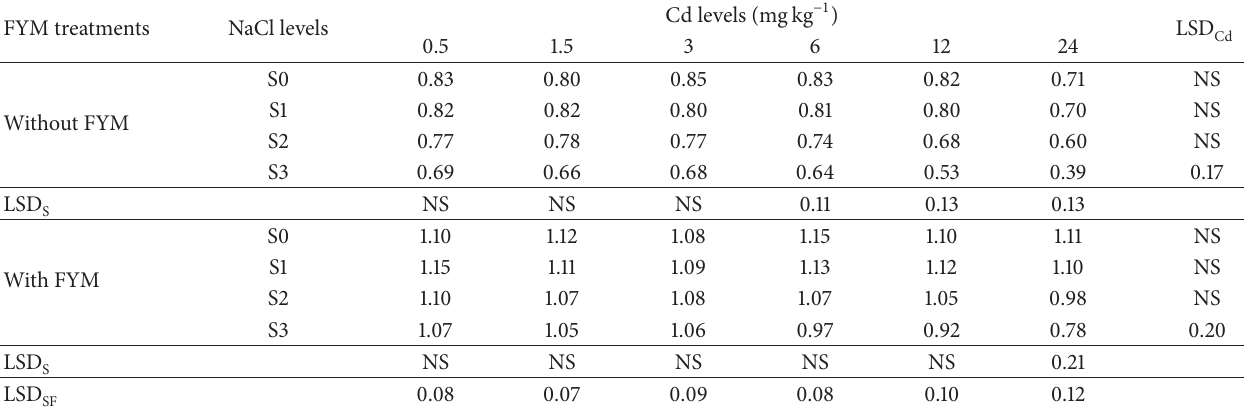
Table 2: Treatment effects on shoot dry matter of barley plants (g pot − 1 ).